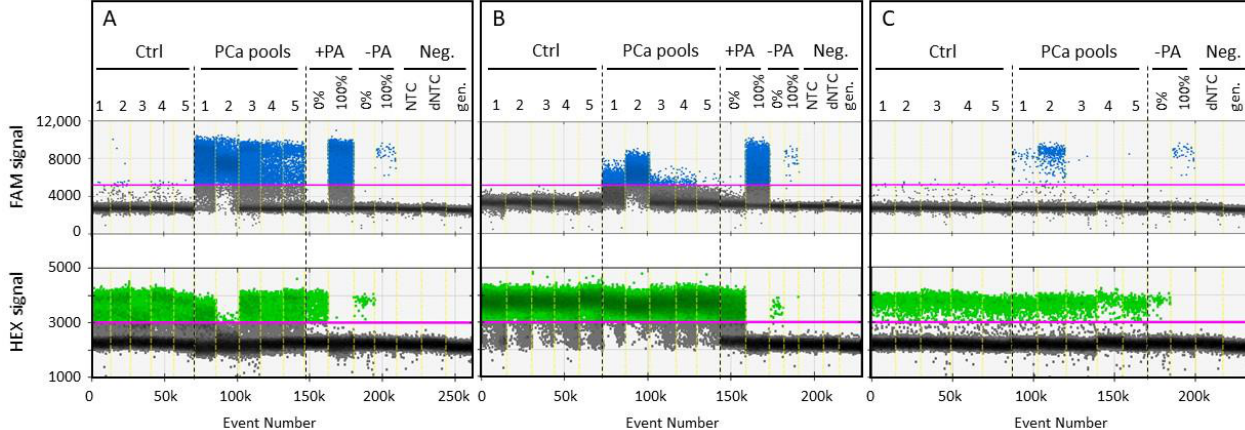
Figure 2. Identification of methylated and unmethylated RASSF1A DNA fragments in healthy controls and PCa serum pools. Thresholds for FAM signals specific for methylated (blue, upper row) and HEX signals for unmethylated (green, lower row) DNA sequences were 5200 and 3000 RFU, respectively. Serum pools of healthy individuals (Ctrl) and prostate carcinoma (PCa) patients were analysed by OBBPA-ddPCR ( A ), ddPCR after unbiased pre-amplification ( B ), and ddPCR alone ( C ). As control measurements, unmethylated (0%) and methylated (100%) DNA standards as well as no-template controls (dNTC without and NTC with pre-amplification) were analysed before ( − PA) and after (+PA) pre-amplification. Genomic DNA standards without prior bisulfite treatment (gen.) were tested by ddPCR to ensure specific detection of bisulfite treated